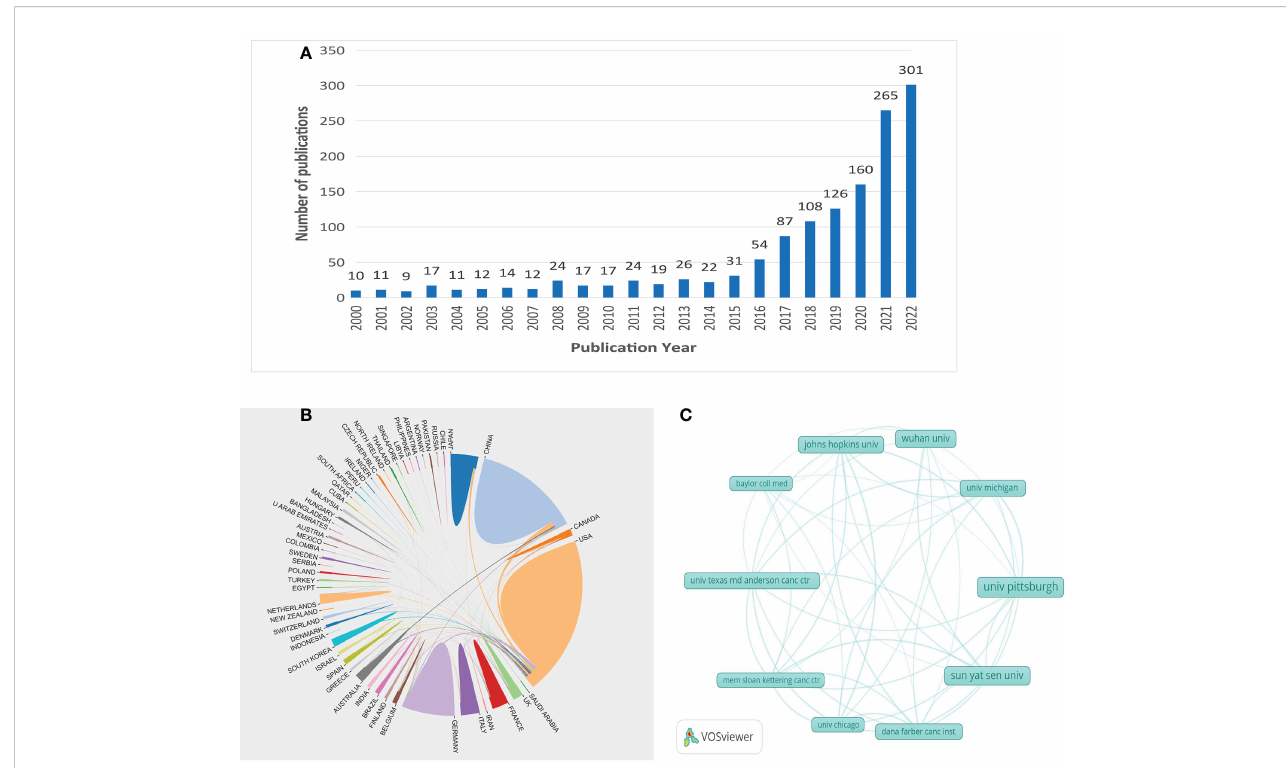
FIGURE 2 From 2000 to 2022, trends in the number of publications in HNSCC immunotherapy research (A) . Analysis of cooperation between countries (B) . Network of institutions engaged in HNSCC immunotherapy research (C)